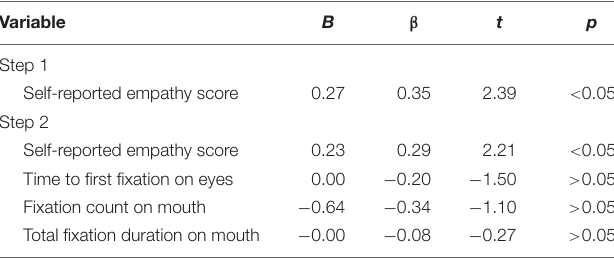
FIGURE 9 | Means of time to first fixation (A) , fixation count (B) , and total fixation duration (C) on painful faces during pain rating task by facial clue and